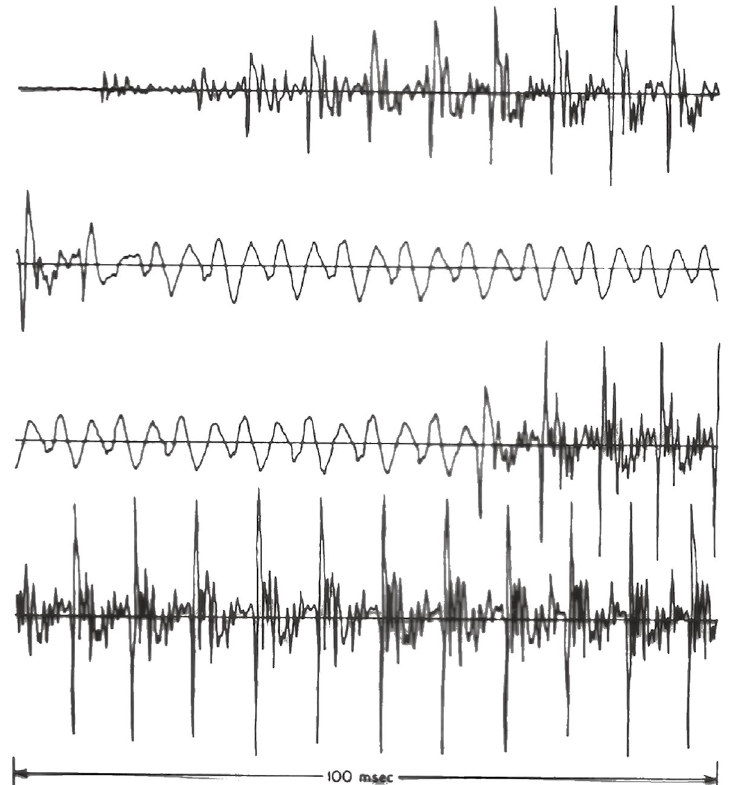
Fig. 1 Example of a speech waveform in time; four successive sections of 100 ms each. Two quasiperiodic strong vowels (10–115 and 260–400 ms) have a nasal (115–260 ms) between them